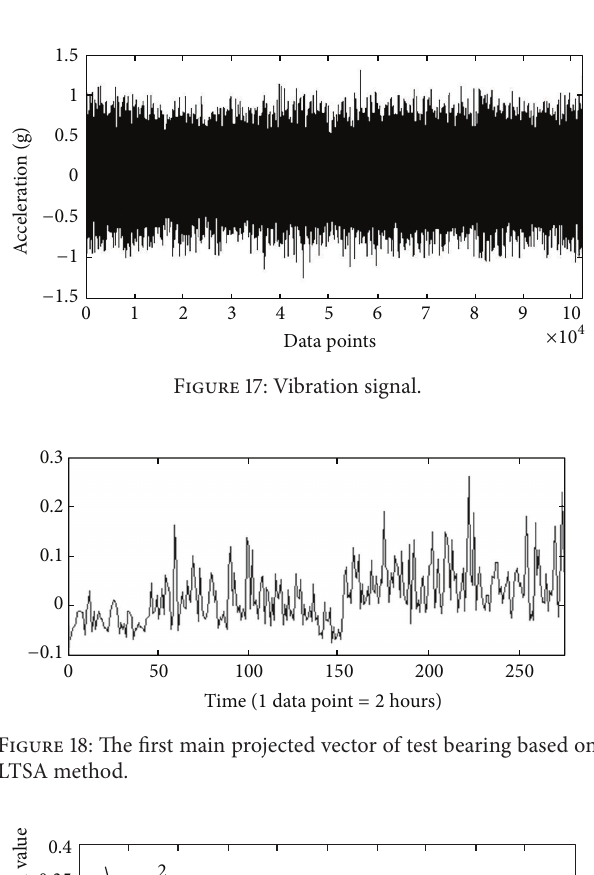
Figure 21: Prediction result based on the SVM